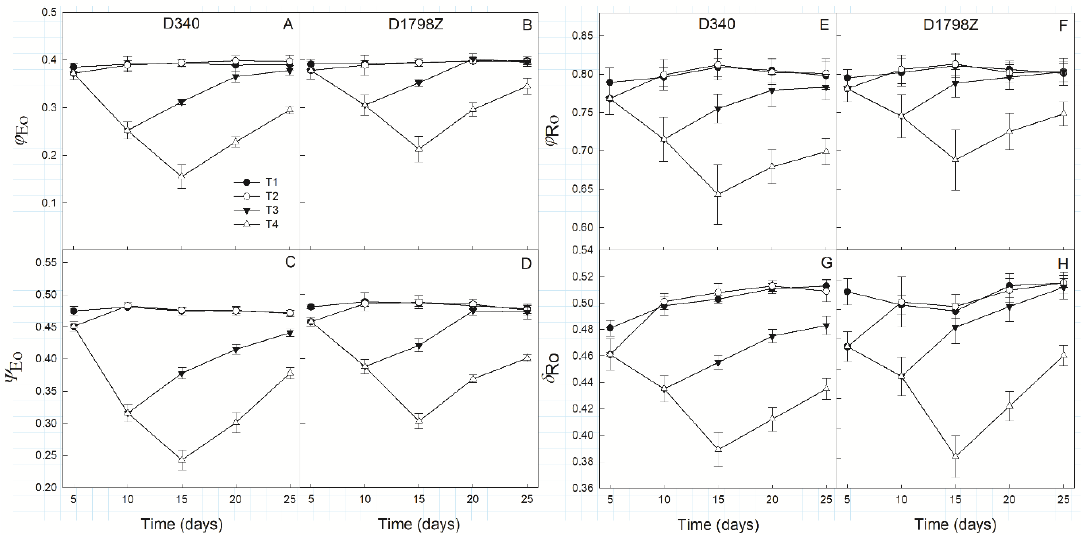
Figure 6. E ff ect of di ff erent drought durations and re-watering on the photosynthetic electron transport chain. ψ Eo , e ffi ciency / probability that an electron moves further than Q A − ( A , B ), ϕ Eo , quantum yield for electron transport ( C , D ), δ Ro , e ffi ciency / probability with which an electron from the intersystem electron carriers is transferred to reduce end electron acceptors at the PSI acceptor side ( E , F ) and ϕ Ro , the quantum yield for the reduction of the end electron acceptors at the PSI acceptor side ( G , H ). Each parameter is the average of three replicates.